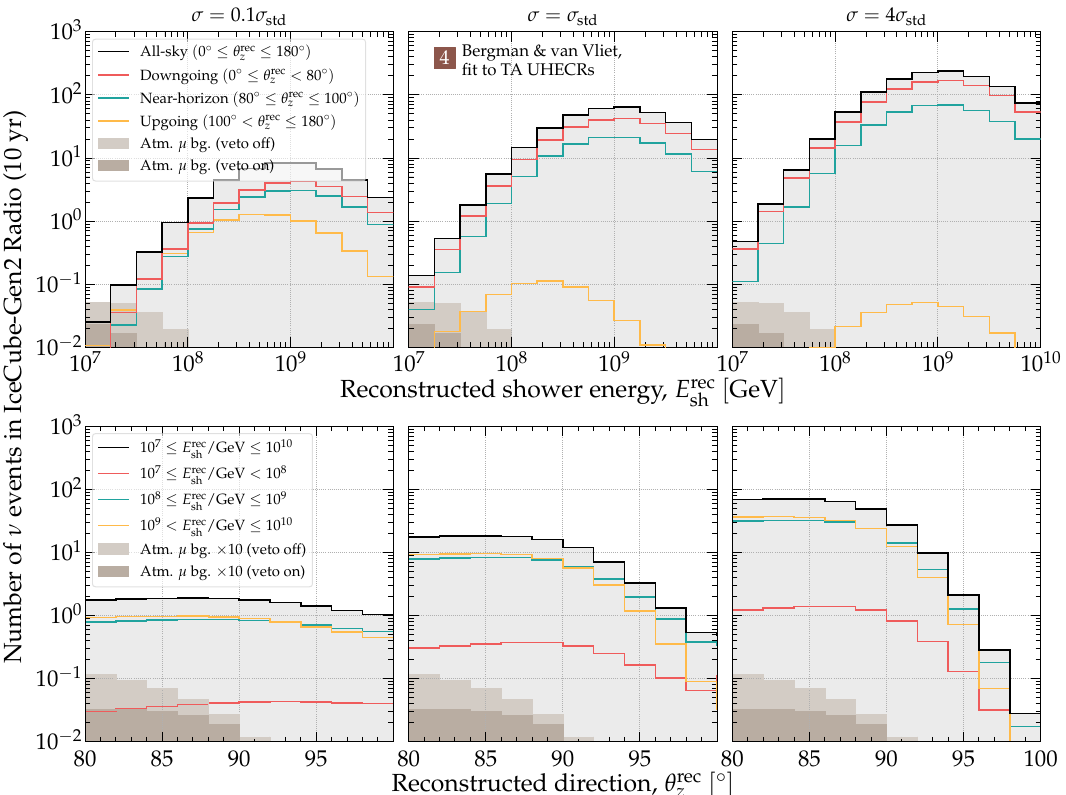
Figure 15 . Mean expected distribution of neutrino-initiated showers in the radio component of IceCube-Gen2 after 10 years of exposure. For this plot, we assume the benchmark model 4 for the UHE diffuse neutrino flux [61] (see figure 5); to produce our results in the main text, we explore all flux models, 1–12 (see section 4, tables 1 and 2). Each column shows a different choice of the νN DIS cross section that affects the propagation of neutrinos through the Earth and their detection. The cross section σ is the central value of the BGR18 calculation [63], which we take as our std baseline. See section 6.4 for details about the calculation of shower rates. We include the background of showers due to atmospheric muons, which factors into our statistical analysis, computed using the hadronic interaction model Sybill 2.3c [175]. (In the lower row of panels, the background is multiplied by a factor of 10 to make it visible.) In our analysis, we use exclusively the background after the application of the surface veto (“veto on”); in this plot, we show the case without the veto (“veto off”) only for